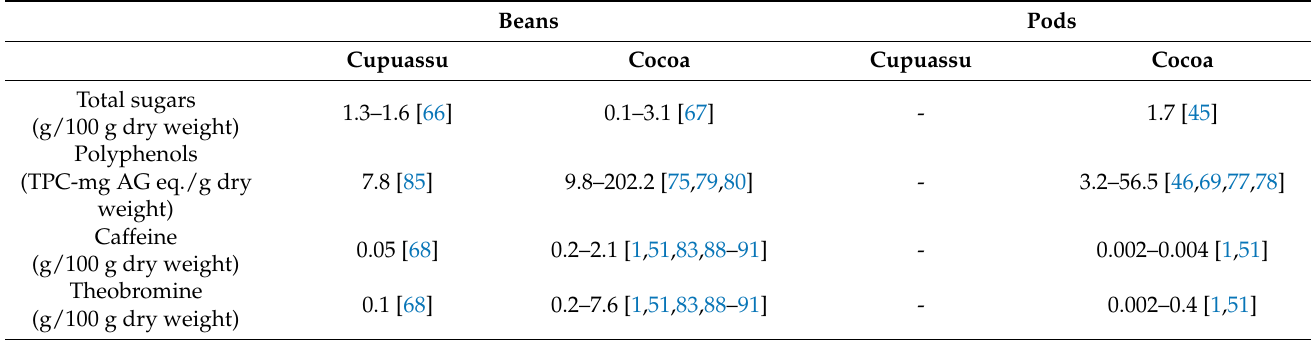
Table 2. Cont. Beans